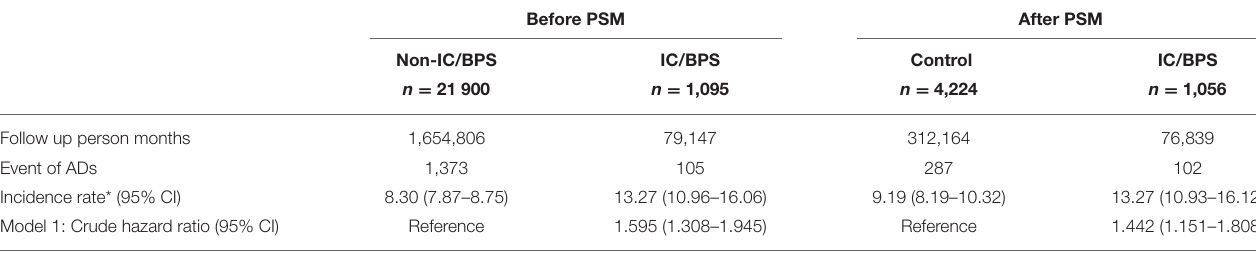
TABLE 2 | Time to event analysis.